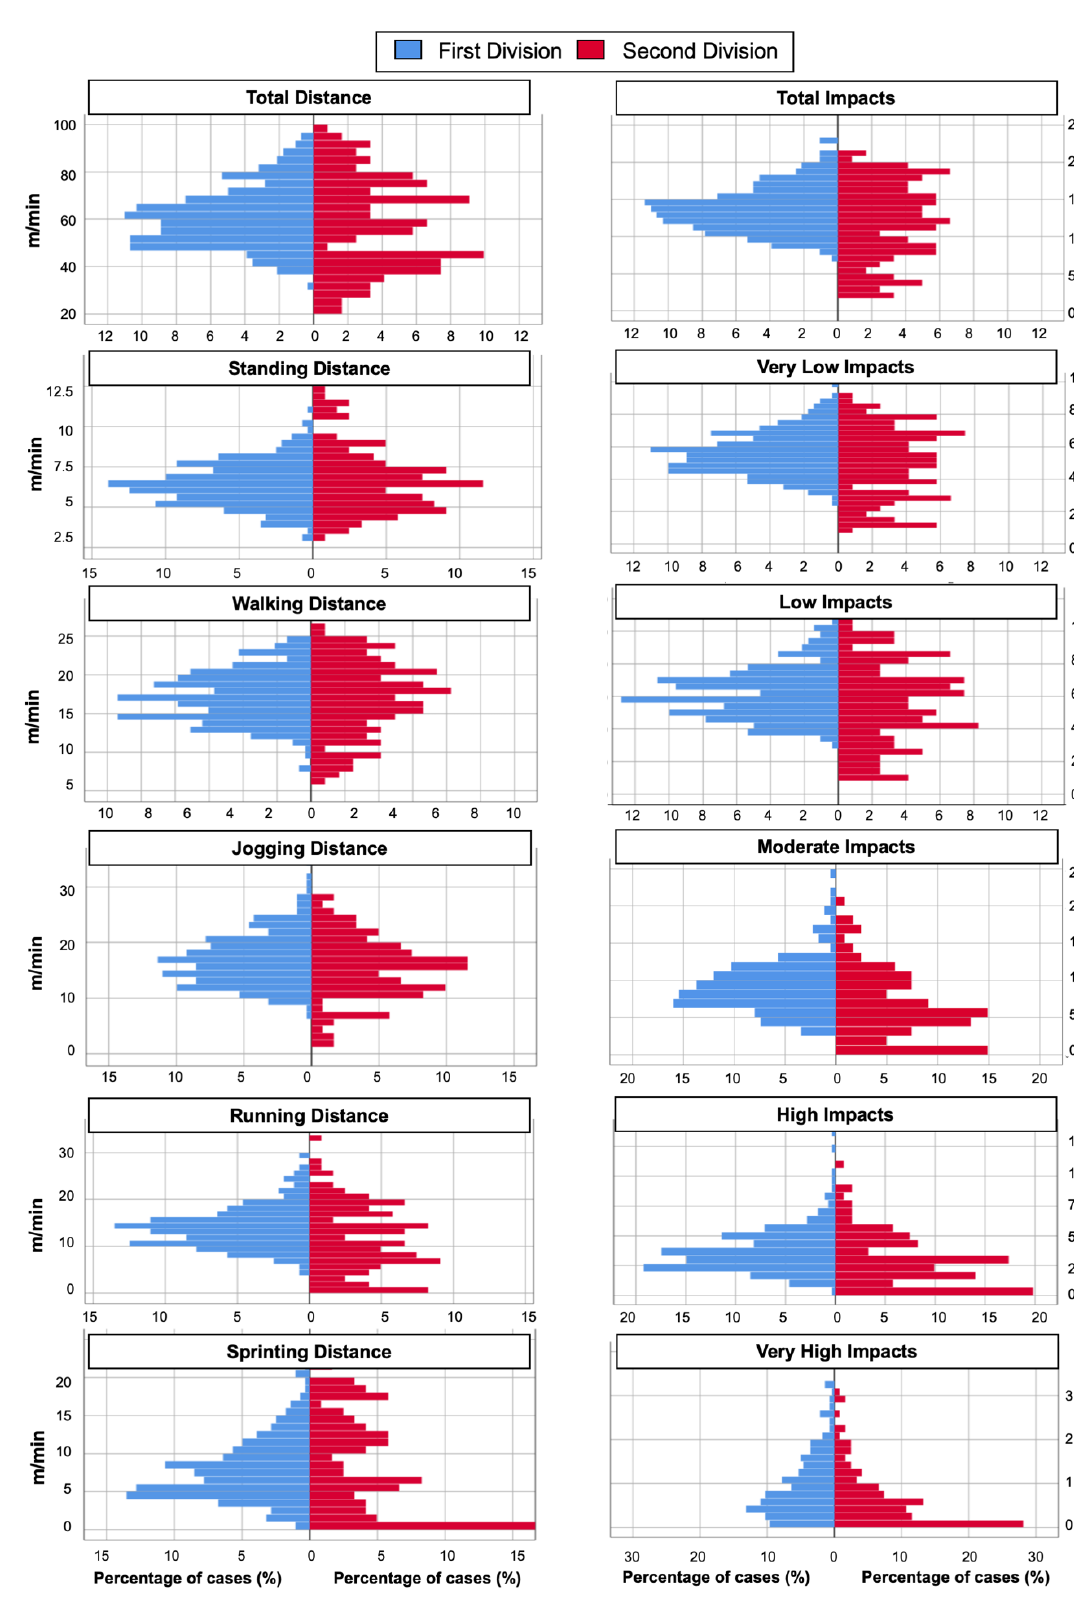
Figure 1. Histogram to represent the external workload demands in five vs. five in women’s basketball in the different speed and impact zones.